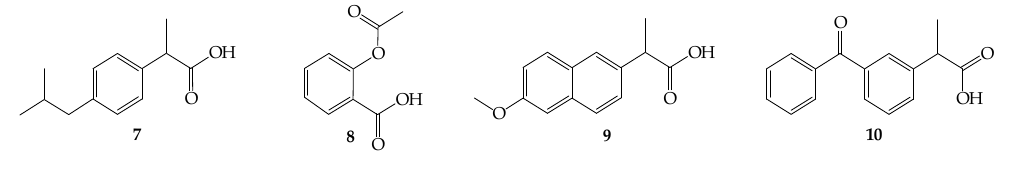
Figure 2. NSAID molecules selected.